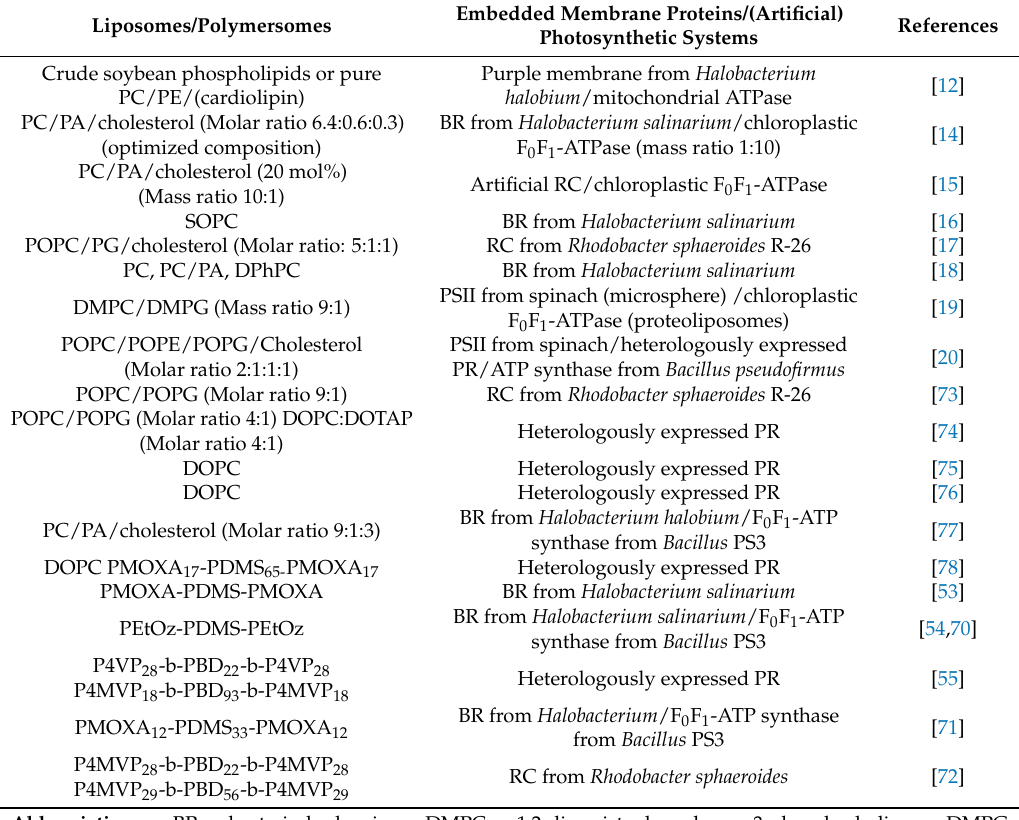
Table 1. List of studies which used liposomes and polymersomes for light-driven biocatalysis by embedding (artificial) photosynthetic